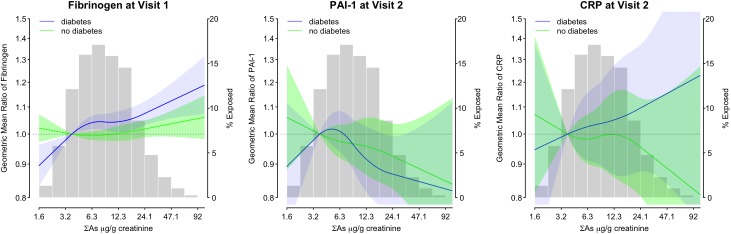
Geometric mean ratios of fibrinogen, PAI-1, and CRP in relation to urine arsenic in the SHS main cohort by diabetes status.Lines represent the geometric mean ratio (GMR) of baseline fibrinogen (left panel), PAI-1 at Visit 2 (center panel), or CRP at Visit 2 (right panel), by log-transformed urine arsenic concentrations (ΣAs, μg/g creatinine), with the 10th percentile (3.6 μg/g creatinine) as the reference. The GMR of baseline fibrinogen concentrations are from a linear mixed model and the GMR of Visit 2 PAI-1, and CRP concentrations are from a linear regression (see statistical methods for details). Arsenic was modeled using restricted quadratic splines of log-transformed urine arsenic (knots at the 10th, 50th, 90th percentiles; 3.6, 8.4, and 22.4 μg/g creatinine, respectively). Models were fully-adjusted for all potential confounders in Model 2 (age, sex, education (no, some, or finished high school), smoking (never, former, current), alcohol drinking (never, former, current), BMI (kg/m2), LDL cholesterol (mg/dL), hypertension (yes/no), eGFR (mL/min/1.73 m2), and study center (AZ, OK, ND/SD).